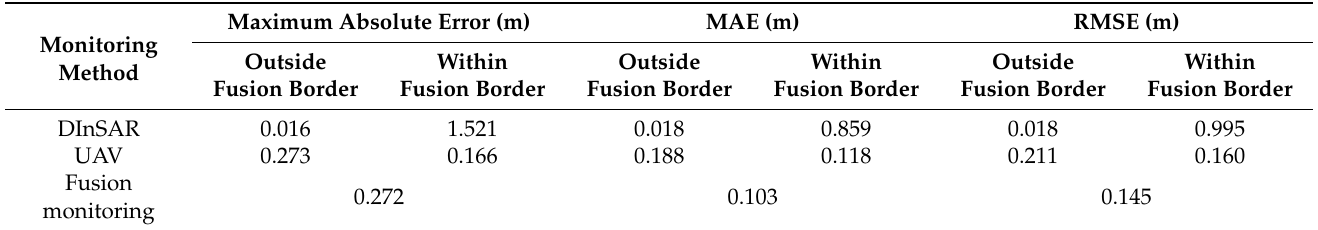
Table 3. Accuracy comparison between the single means and fusion monitoring along line